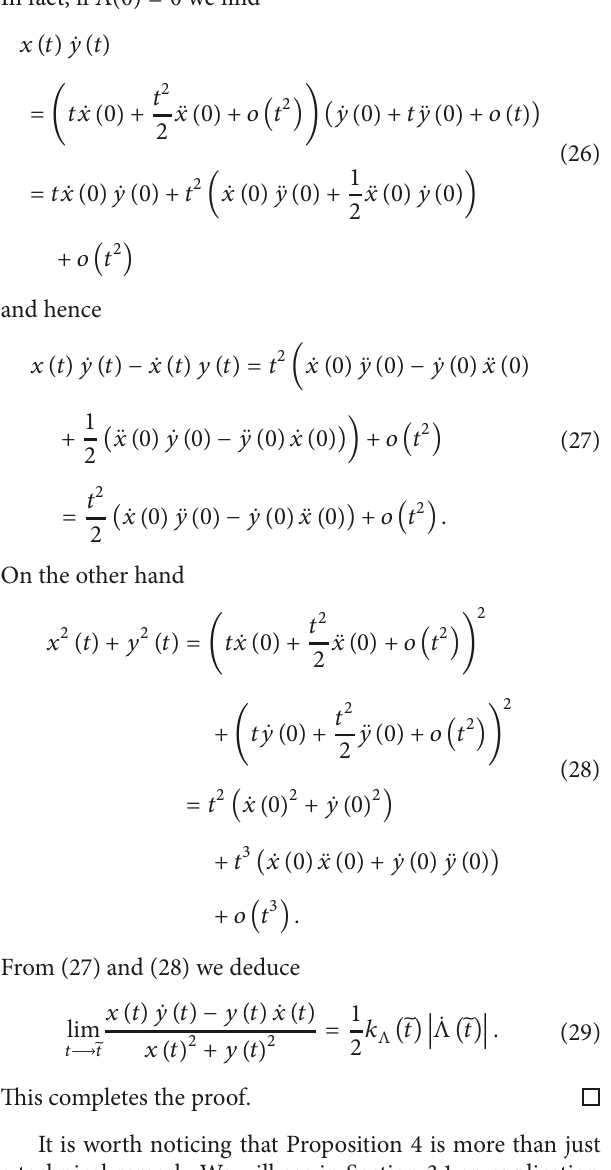
Figure 6: The (solid) curve from Example 5 has winding number 3/2 with respect to the origin, and the dashed and dotted ones have winding numbers 2 and 1,